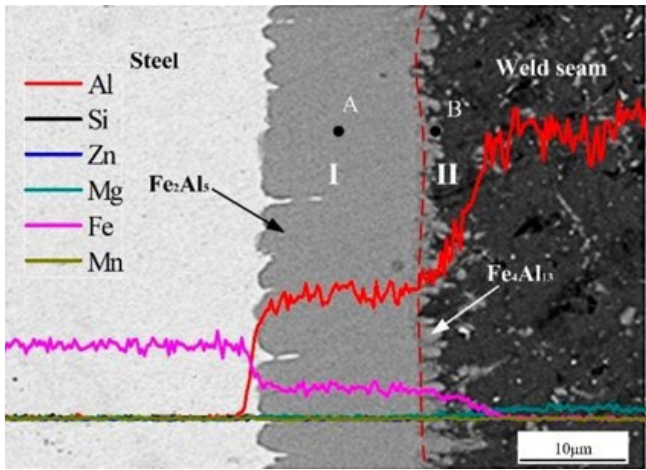
Figure 3. Interfacial IMC and EDS analysis location of 1.2 kJ/cm.